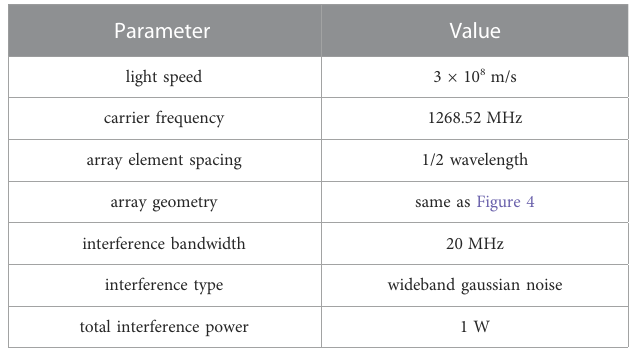
TABLE 4 Settings of simulation